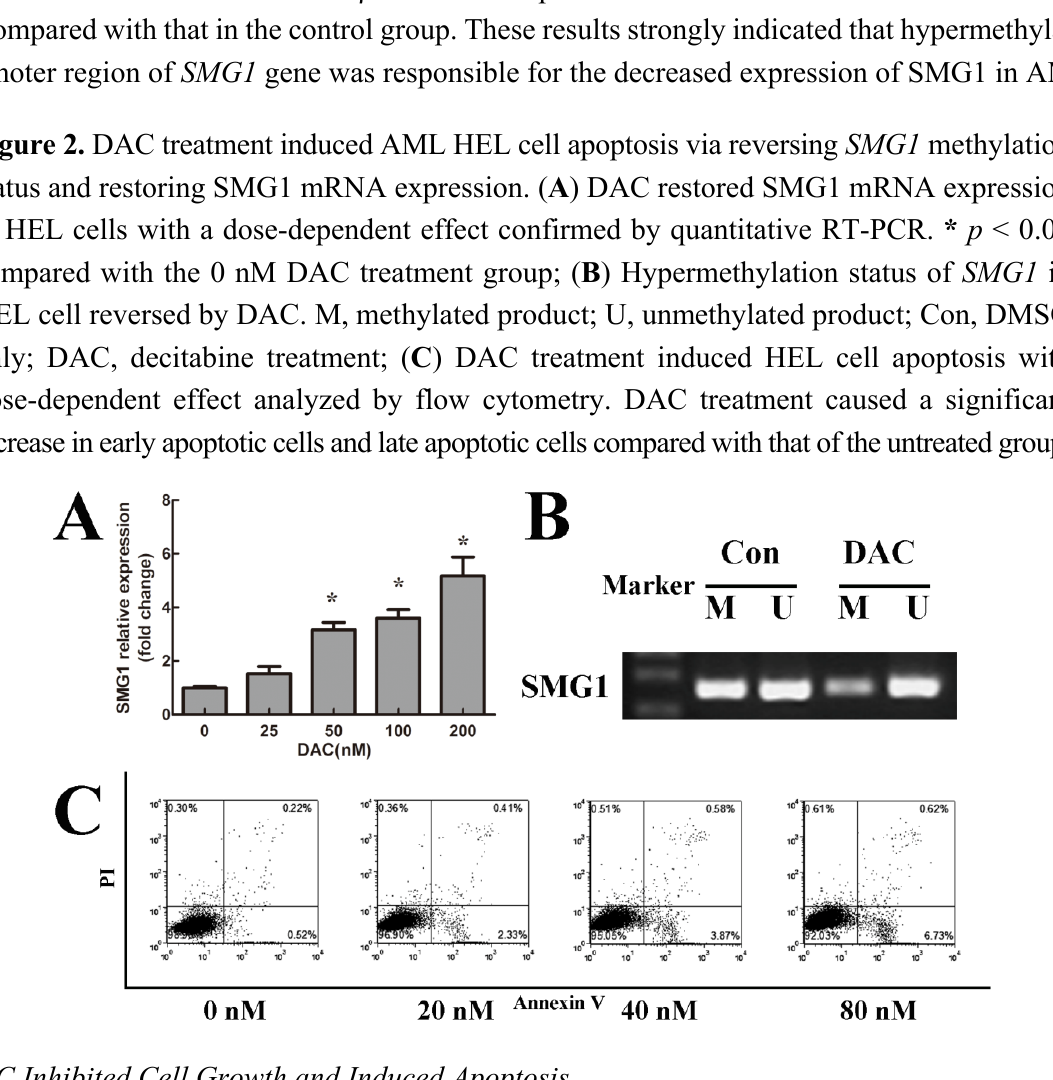
Figure 2. DAC treatment induced AML HEL cell apoptosis via reversing SMG1